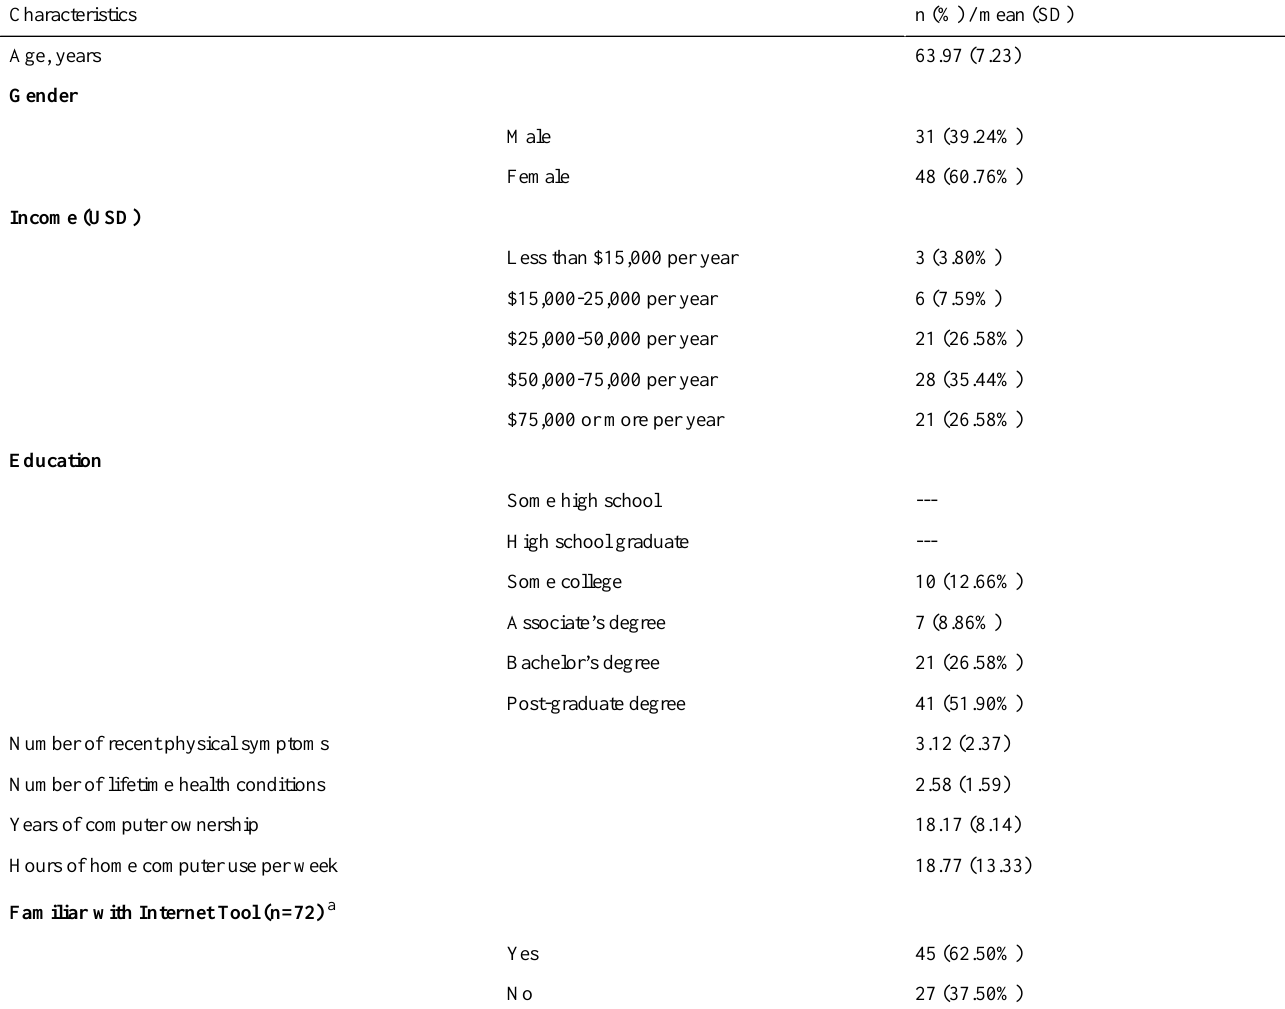
Table 1. Participant characteristics